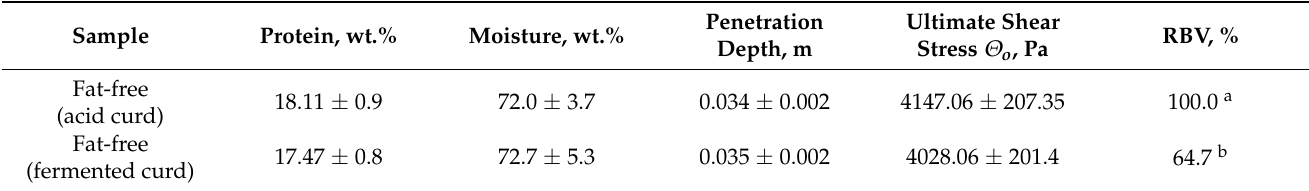
Table 5. Physical, chemical, rheology, and biological properties of the acid and fermented curd sam- ples. a,b : Means in columns which do not share the same superscript letter are significantly different.